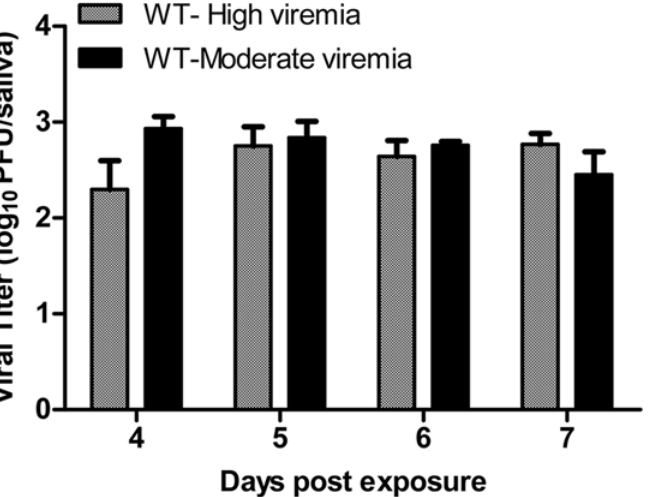
Fig 3. Viral titers in saliva of WT mosquitoes at different days after peroral infection with 6.90 or 9.00 log 10 PFU/ml of CHIKV. Error bars represent the Bootstrap 95% confidence interval for the